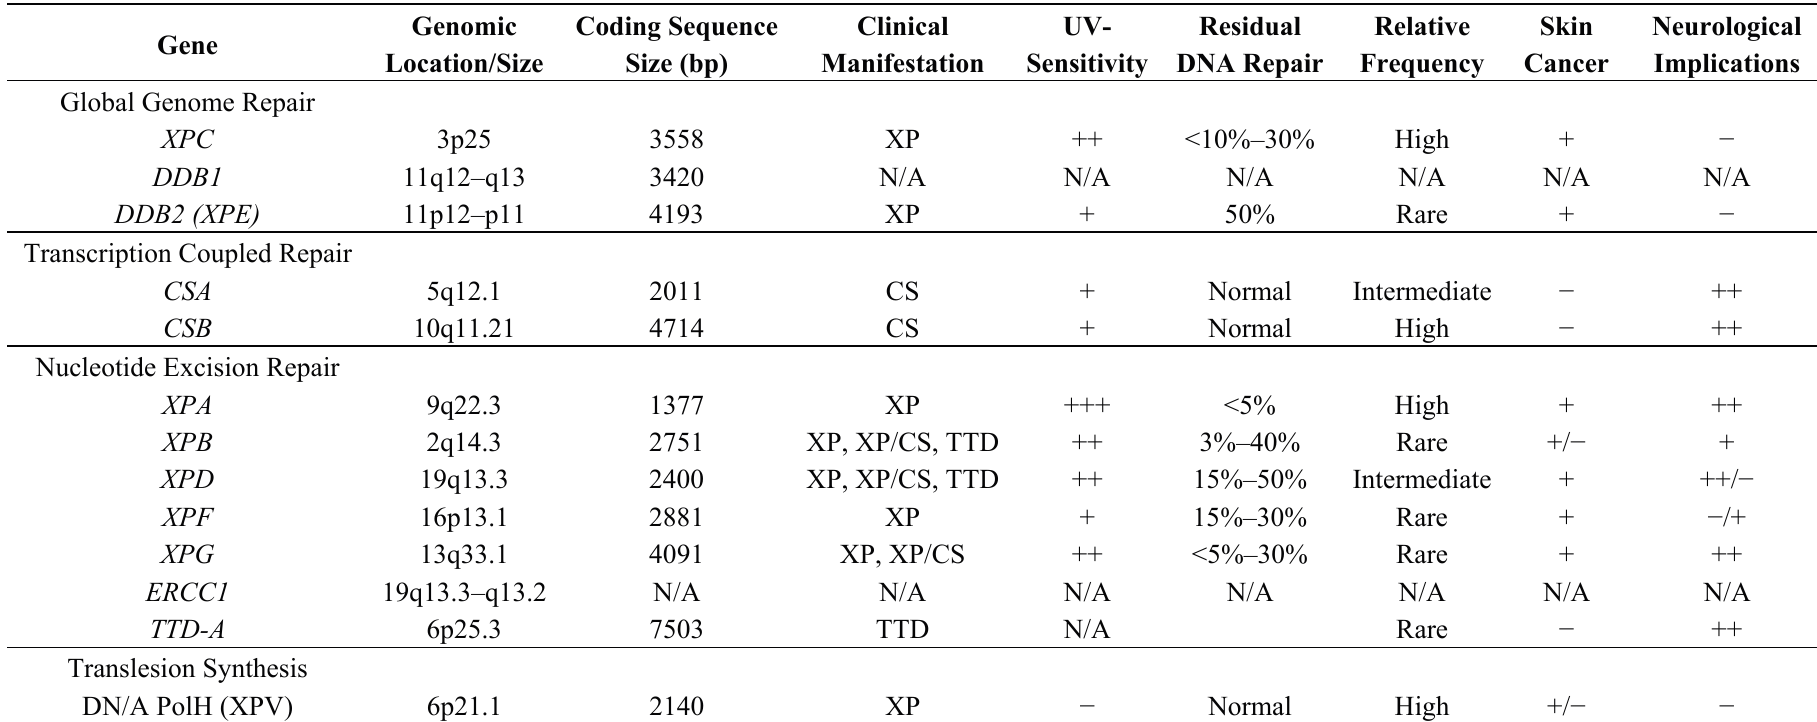
Table 1. Genes involved in xeroderma pigmentosum, Cockayne’s syndrome and trichothiodystrophy.